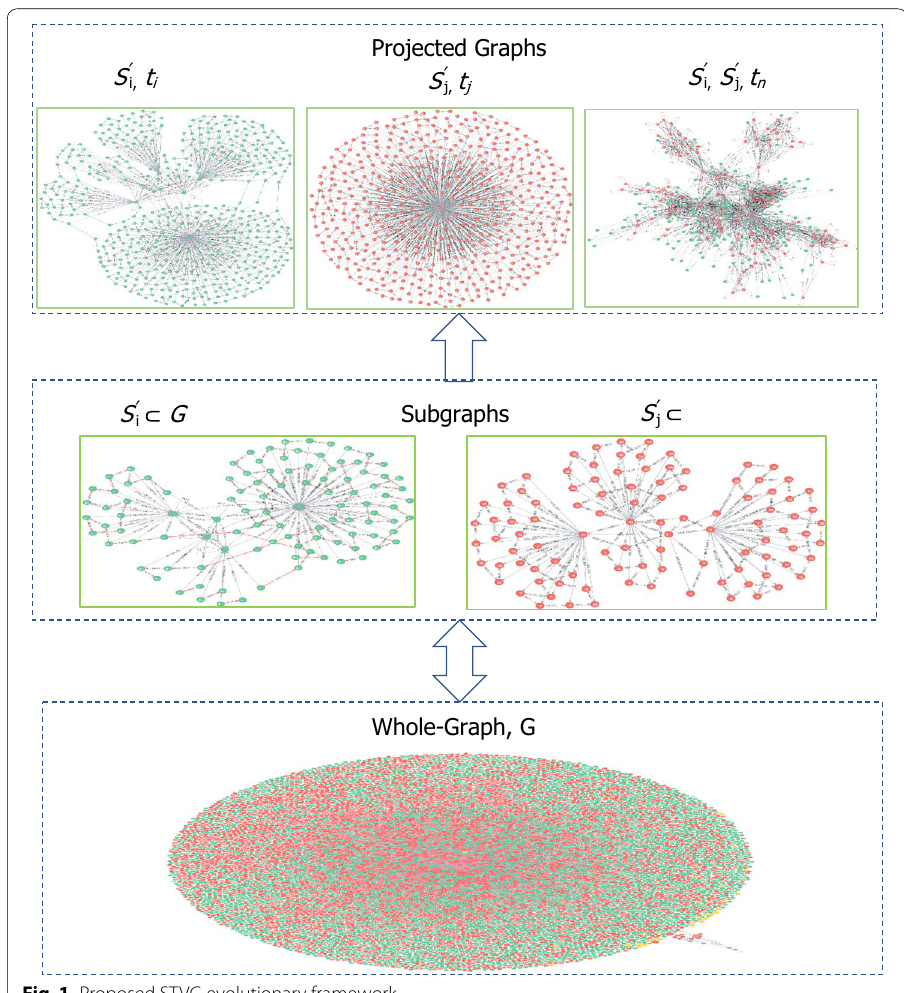
Fig. 1 Proposed STVG evolutionary